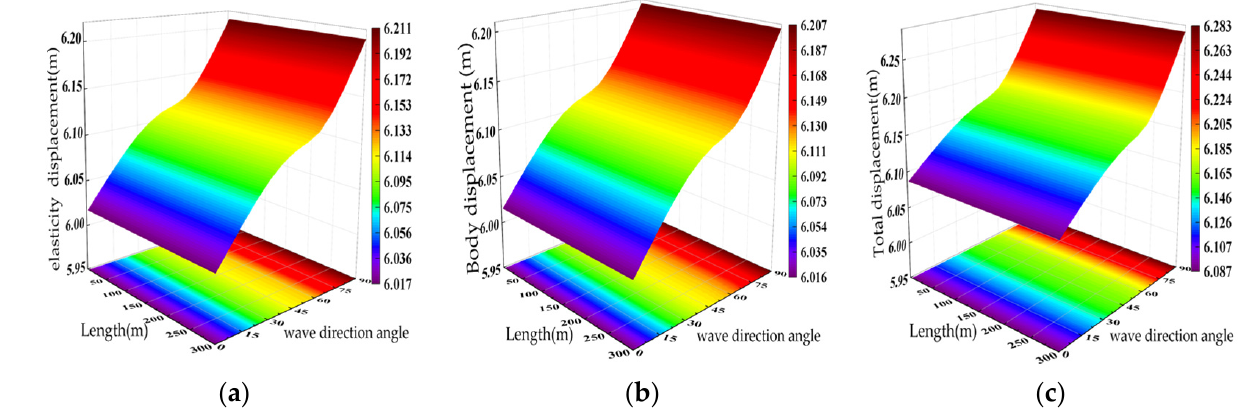
Figure 12. Three-dimensional cloud map of the variation of vertical displacement amplitude with